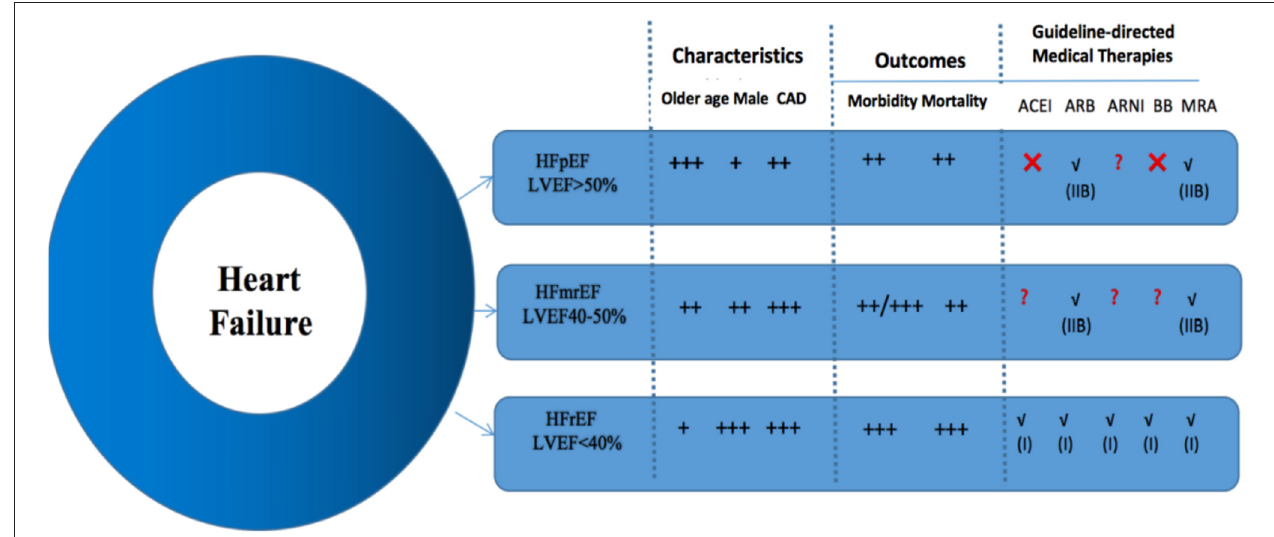
FIGURE 2 | General comparisons of the clinical characteristics, outcomes, and guideline-directed medical therapies for each heart failure group. Class of recommendation is denoted in parentheses, if applicable. ACEI, angiotensin-converting enzyme inhibitors; ARB, angiotensin receptor blocker; ARNI, angiotensin receptor-neprilysin inhibitor; BB, beta-blockers; CAD, coronary artery disease; HFmrEF, heart failure with mid-range ejection fraction; HFpEF, heart failure with preserved ejection fraction; HFrEF, heart failure with reduced ejection fraction; MRA, mineralocorticoid receptor antagonist.